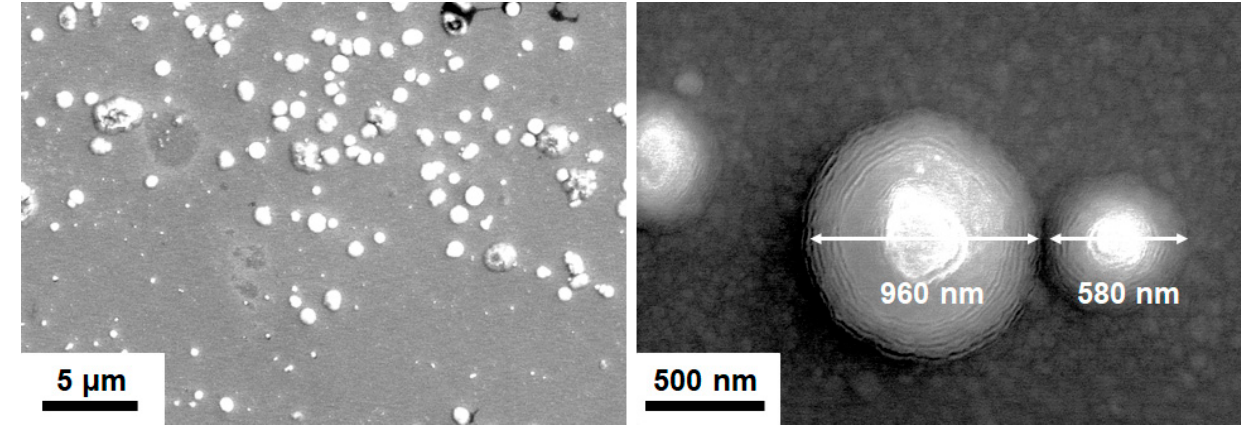
Figure 11. SEM images of the T2 samples annealed at 600 °C in 1% O 2 –Ar for 8 h.